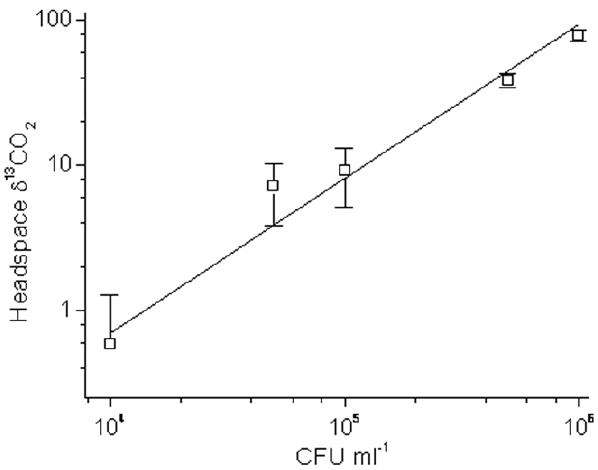
Figure 1. Mycobacterial urease assay by conversion of [ 13 C] urea to 13 CO 2 reports upon CFU over a wide range. M. bovis BCG was incubated for 30 minutes with 5 mg ml 2 1 [ 13 C]-urea and headspace gas sampled and analysed for 13 CO 2 enrichment (reported as d 13 CO 2 ).